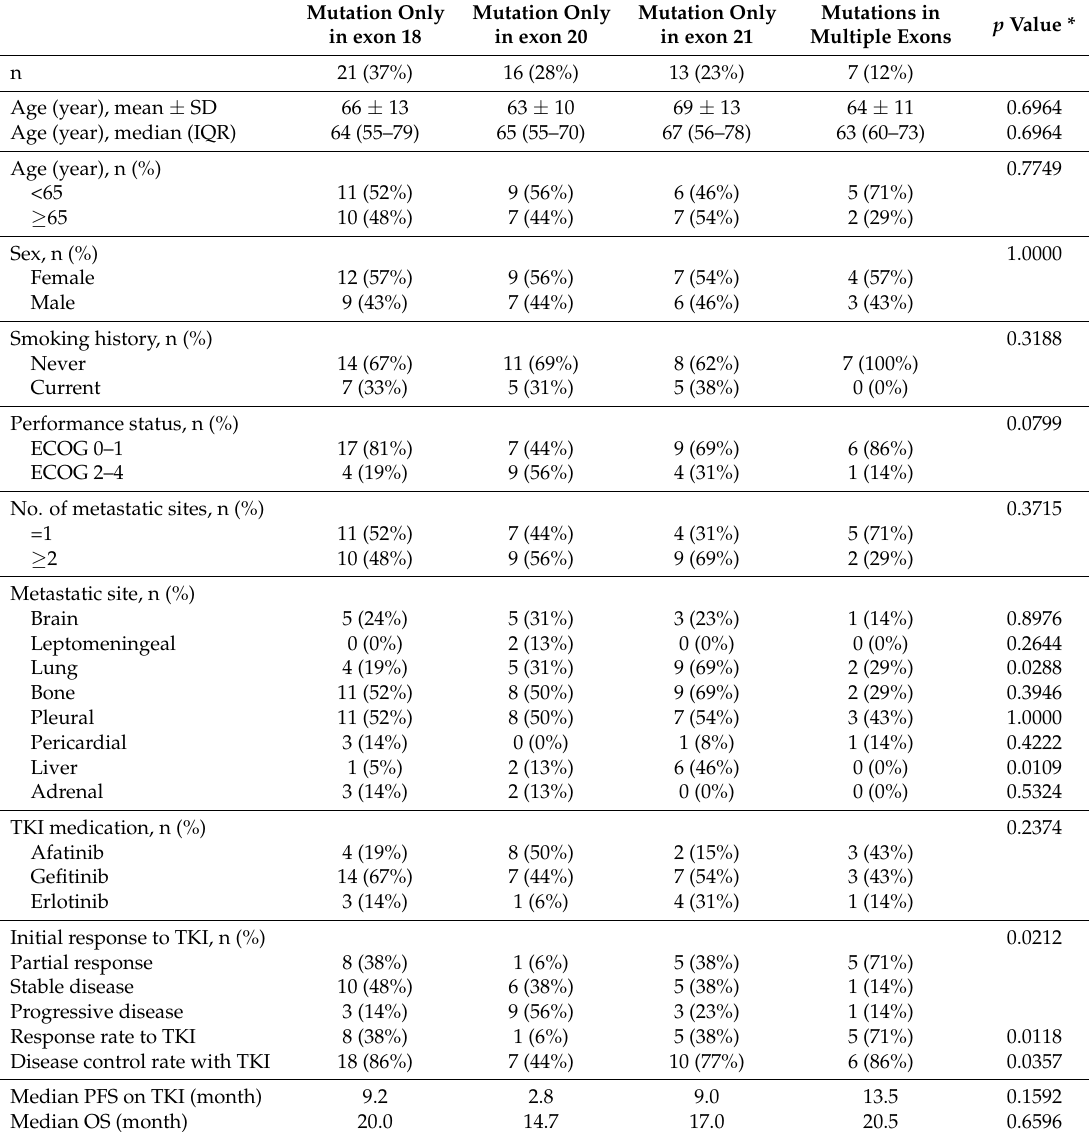
Table 2. Characteristics of the patients with stage IV lung cancer harboring uncommon mutation receiving a first-line tyrosine kinase inhibitor (TKI), classified by the exon of epidermal growth factor receptor ( EGFR )